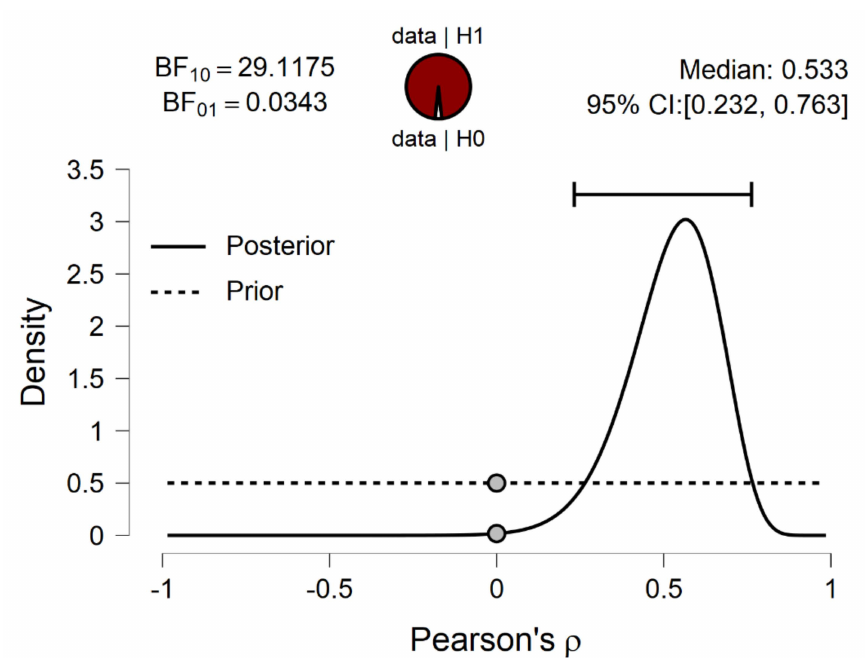
Figure 2. Prior and posterior of Bayesian correlation